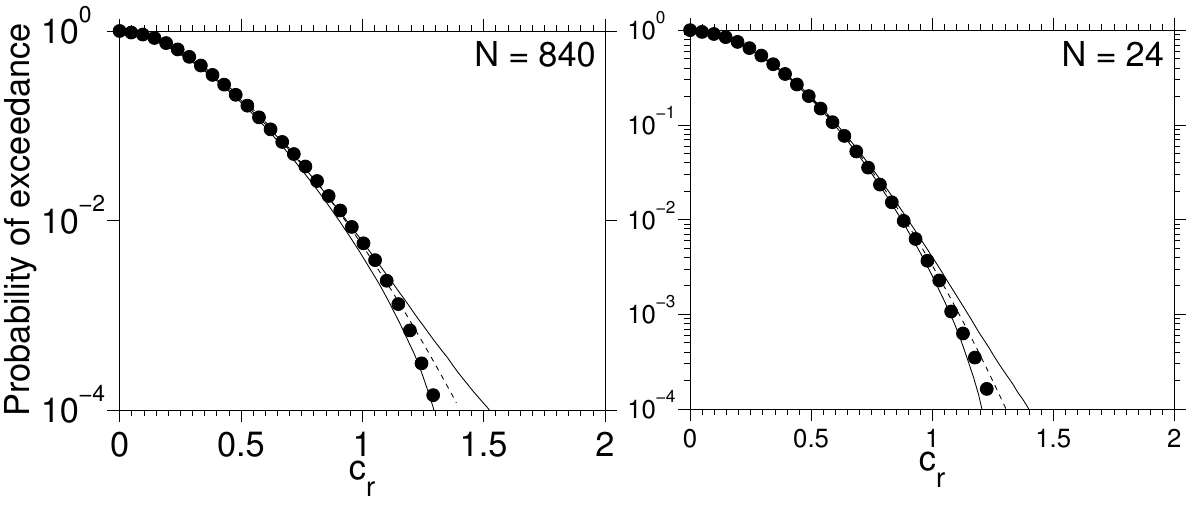
Fig. 8. Weibull fit (dashed line) and 95% confidence intervals (solid line) for the wave crest distribution (circles) associated to a nominal sea state with k p H s / 2 = 0 .